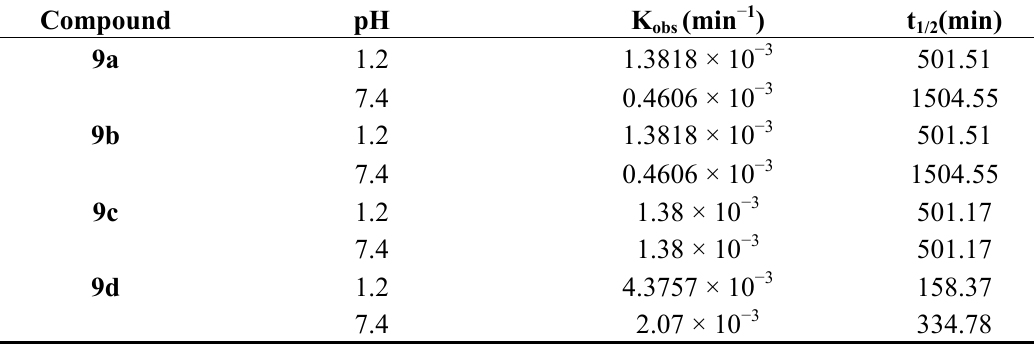
Table 1. Kinetic data for the chemical hydrolysis of the compounds ( 9a – d ).